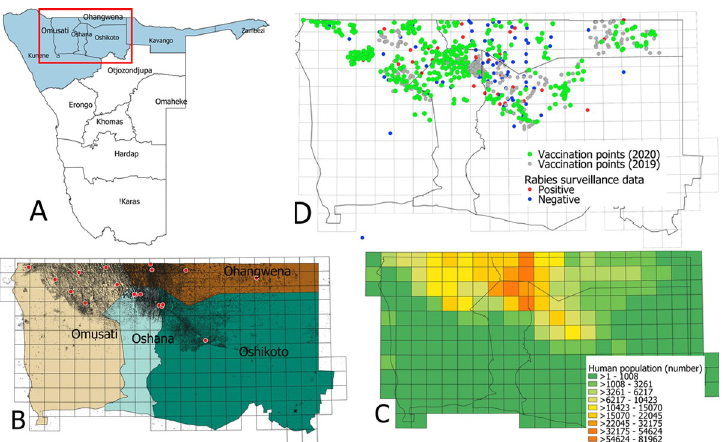
Fig 1. Study area for mass dog vaccination campaigns in Namibia. Map depicting the location of the greater study area (red rectangular) in Namibia and the boundaries and names of the Namibian regions ( A ), grid cells (20 x 20 km) based map of the enlarged area showing the human population distribution (black dots) in the four study regions with the location of towns (red dots) and the rest of the areas are the rural settlements ( B ), grid level human population number ( C ), and the cumulative rabies surveillance data for the time period 2018–December 2019 and the exact location of vaccination points during 2019 and 2020 vaccination campaigns ( D ).